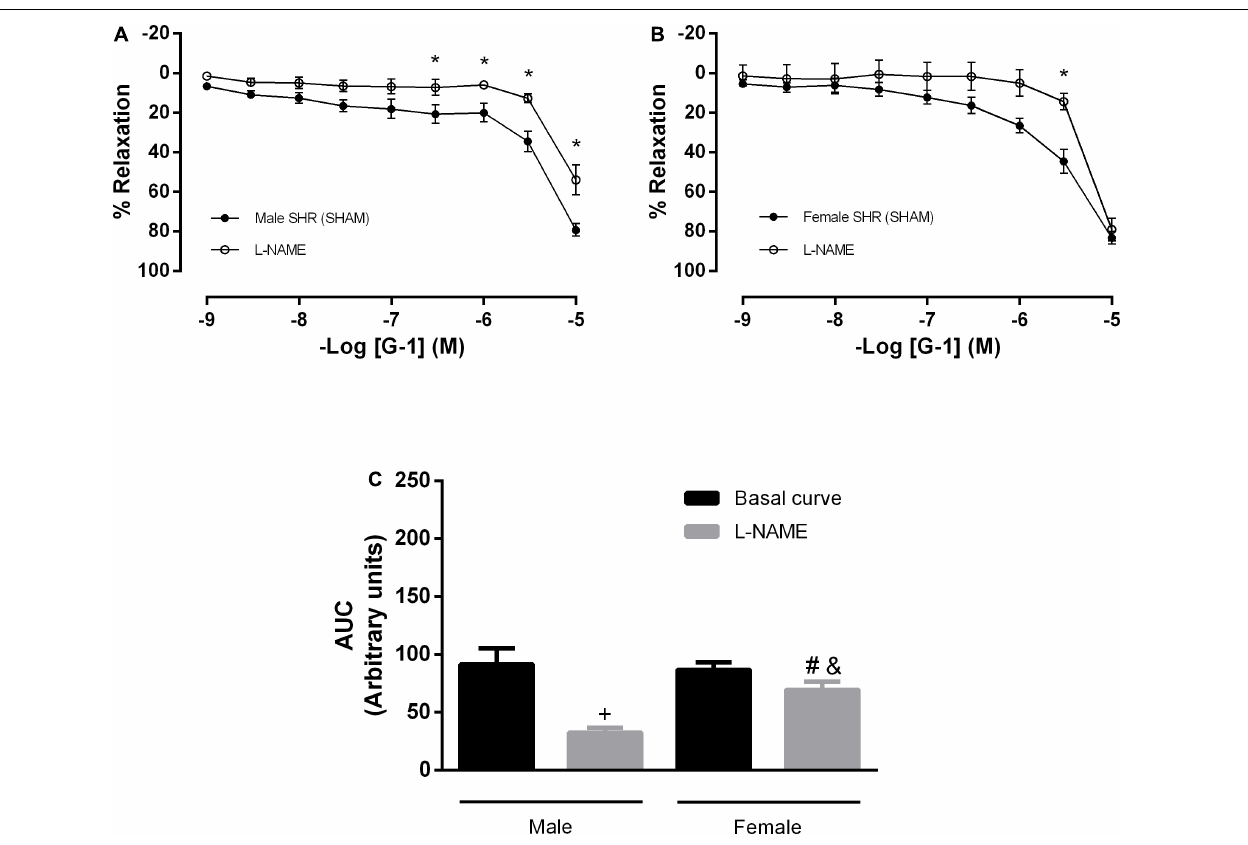
FIGURE 3 | The vasodilator response induced by G-1 is partially dependent on the NO pathway in both sexes, but with a greater participation in male SHR. Effect of non-selective nitric oxide synthase inhibition with N ω -nitro-L-arginine methyl ester (L-NAME, 300 µ M) in (A) Male ( n = 8) and (B) Female ( n = 6) SHR groups. (C) Area under the curve (AUC) before and after 30 min with L-NAME incubation. Values are expressed as mean ± SEM. * P < 0.05 compared to the same dose in the control curve, + P < 0.05 compared to the AUC of the Male SHR control curve, # P < 0.05 compared to the AUC of the Female SHR control curve and & P < 0.05 compared to the AUC of the Male SHR group after L-NAME incubation. The curve analysis was carried out point-by-point through two-way ANOVA, followed by the Sidak post hoc test. AUCs were evaluated through one-way ANOVA followed by Tukey post hoc test.